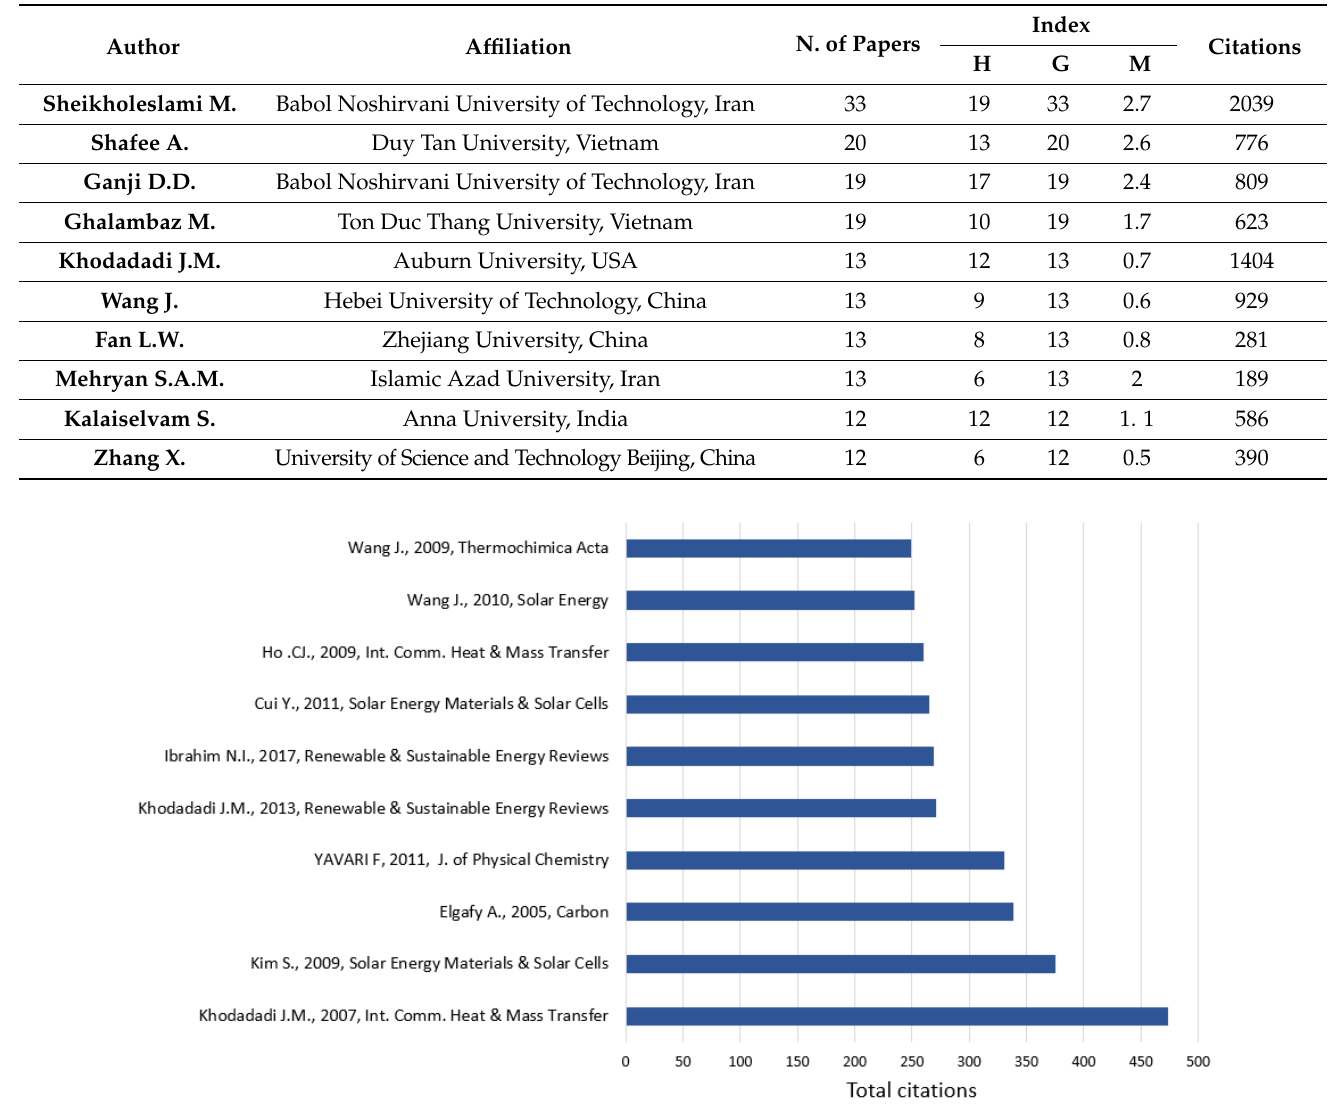
Figure 10. Ten high-cited publications in the NePCM field are Khodadadi and Hosseinizadeh [20], Kim and Drzal [44], Elgafy and Lafdi [25], Yavari et al. [45], Khodadadi et al. [22], Ibrahim et al. [46], Cui et al. [47], Ho and Gao [48], Wang et al. [49], and Wang et al. [50].